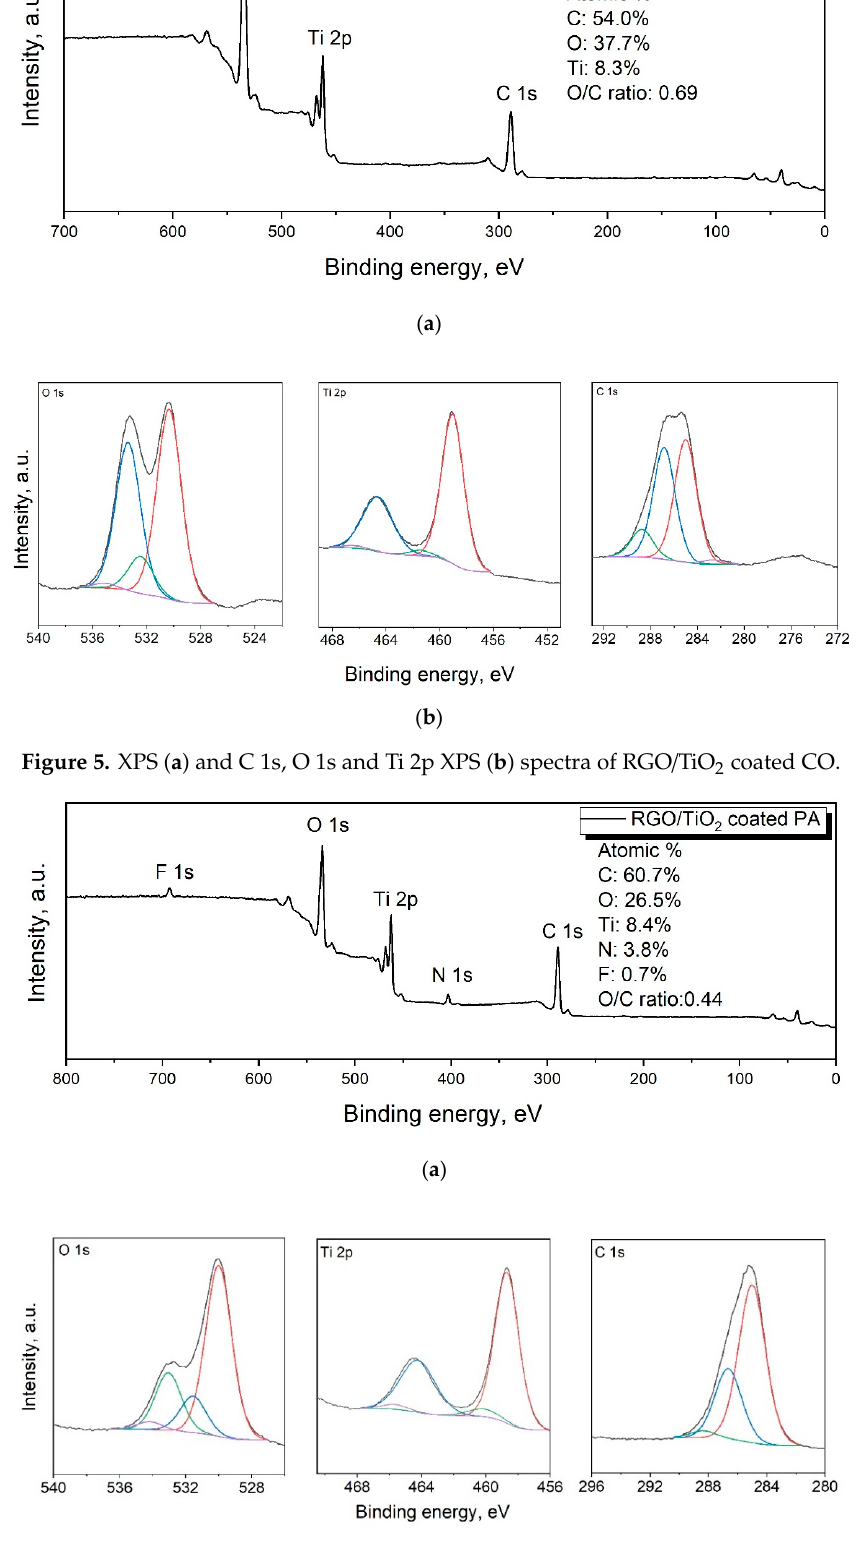
Figure 6. XPS ( a ) and C 1s, O 1s and Ti 2p XPS ( b ) spectra of RGO/TiO 2 coated PA. Table 2. Deconvoluted XPS data of coated fabrics (A smart-type background subtraction model was used to obtain the XPS signal intensity of each individual peaks. Subsequently, an asymmetric Gaussian/Lorentzian function at a constant ratio G/L = 0.35 was used for the deconvolution procedure. All measured BEs were calibrated to the position of C 1s peak at 285.0 eV).